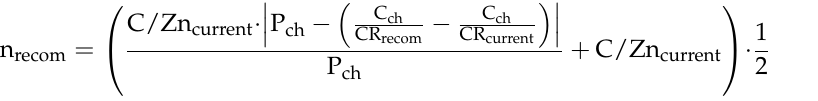
Figure 9. Operation point adjustment by fuel rate minimization model in a one-hour cycle. Firstly, the model checks if the operating point of the furnace is placed between vertical blue lines. If not, it is recommended to adjust the oxygen addition. The addition of oxygen deteriorates the direct reduction rate; however, subtracting oxygen does so inversely. If the oxygen addition is not in use currently, the regulation cycle is ended. In contrast, if the operation point is placed in the area d DRopt ± 7.5%, and the current coke consumption is greater than 15 kg/tZn, the model recommends increasing the charge according to (22):